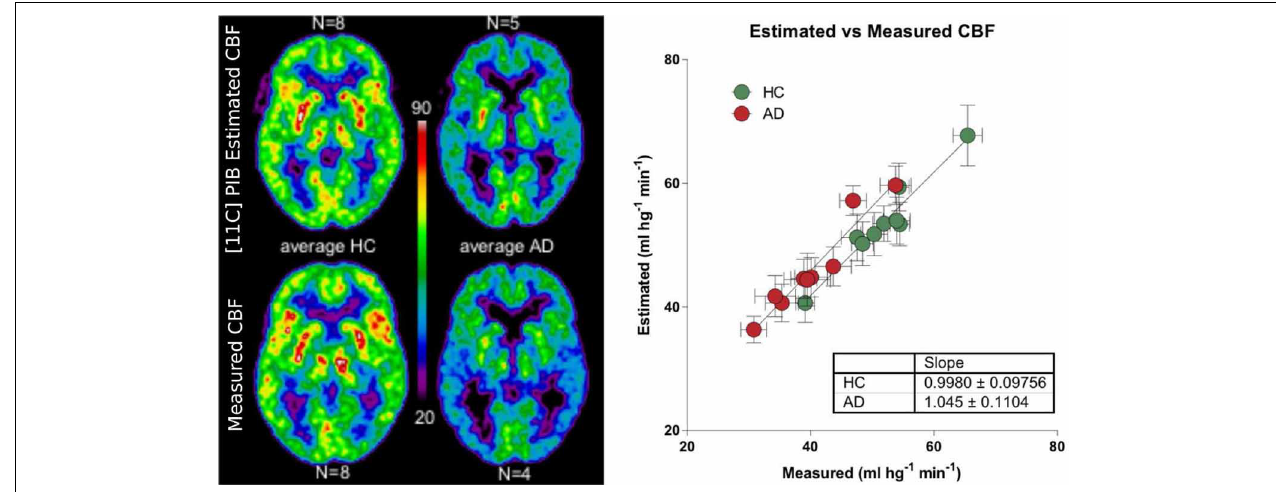
and AD patients (ml hg − 1 min − 1 ). Right panel shows the linear relationship between the different regions averaged for the HC and AD